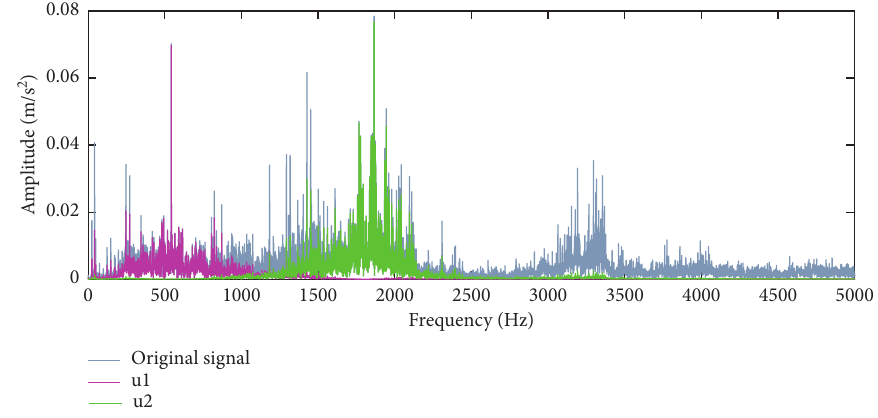
Figure 21: Experimental signals of case 1: the spectrum of each component based on